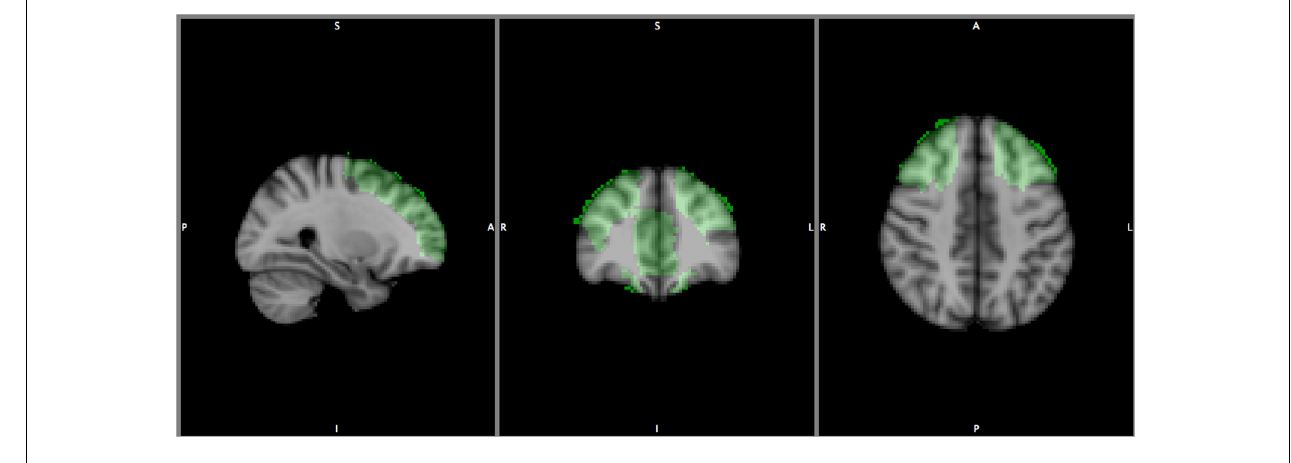
FIGURE 1 | Represents the areas of the inhibitory circuitry.